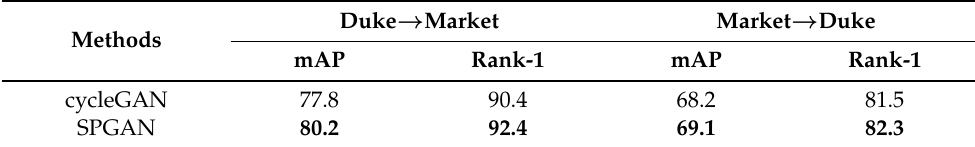
Table 6. The comparison of UDA performance between cycleGAN and SPGAN. Duke → Market Market → Duke Methods mAP Rank-1 mAP Rank-1